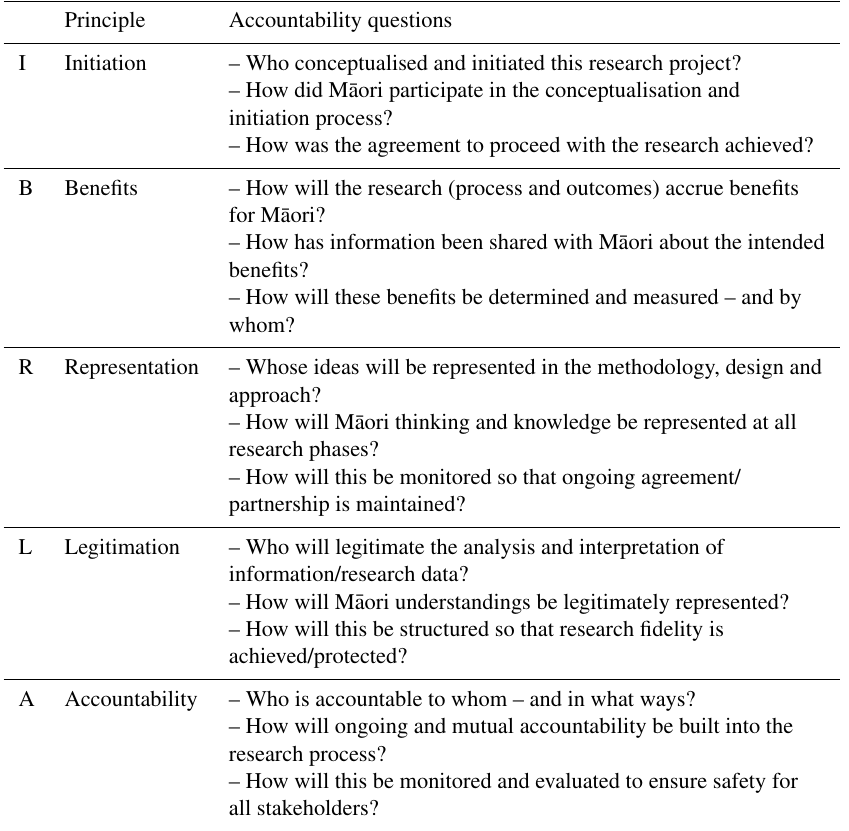
Table 3. The IBRLA framework. Adapted from Macfarlane and Macfarlane (2018).